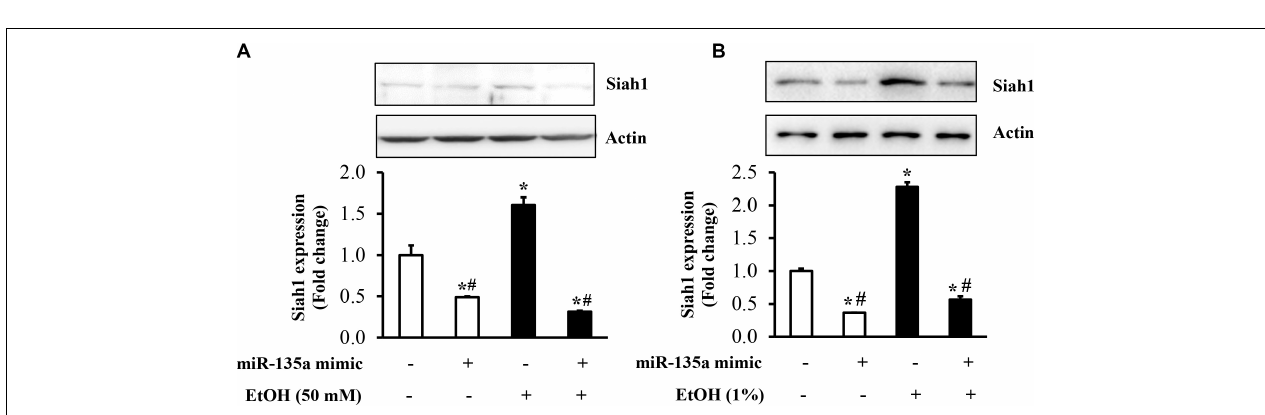
FIGURE 3 | Overexpression of miR-135a significantly decreased the ethanol-induced upregulation of Siah1 in neural crest cells (NCCs) and zebrafish embryos. NCCs transfected with control mimics or miR-135a mimics were treated with 50 mM ethanol for 24 h. Zebrafish embryos microinjected with control or miR-135a mimics were treated with 1% ethanol and collected at 24 h post-fertilization (hpf). The protein expression of Siah1 was examined in NCCs (A) and zebrafish embryos (B) by western blot. Data are expressed as fold change over control and represent the mean ± SD of three separate experiments. * p < 0.05 vs. control; # p < 0.05 vs.